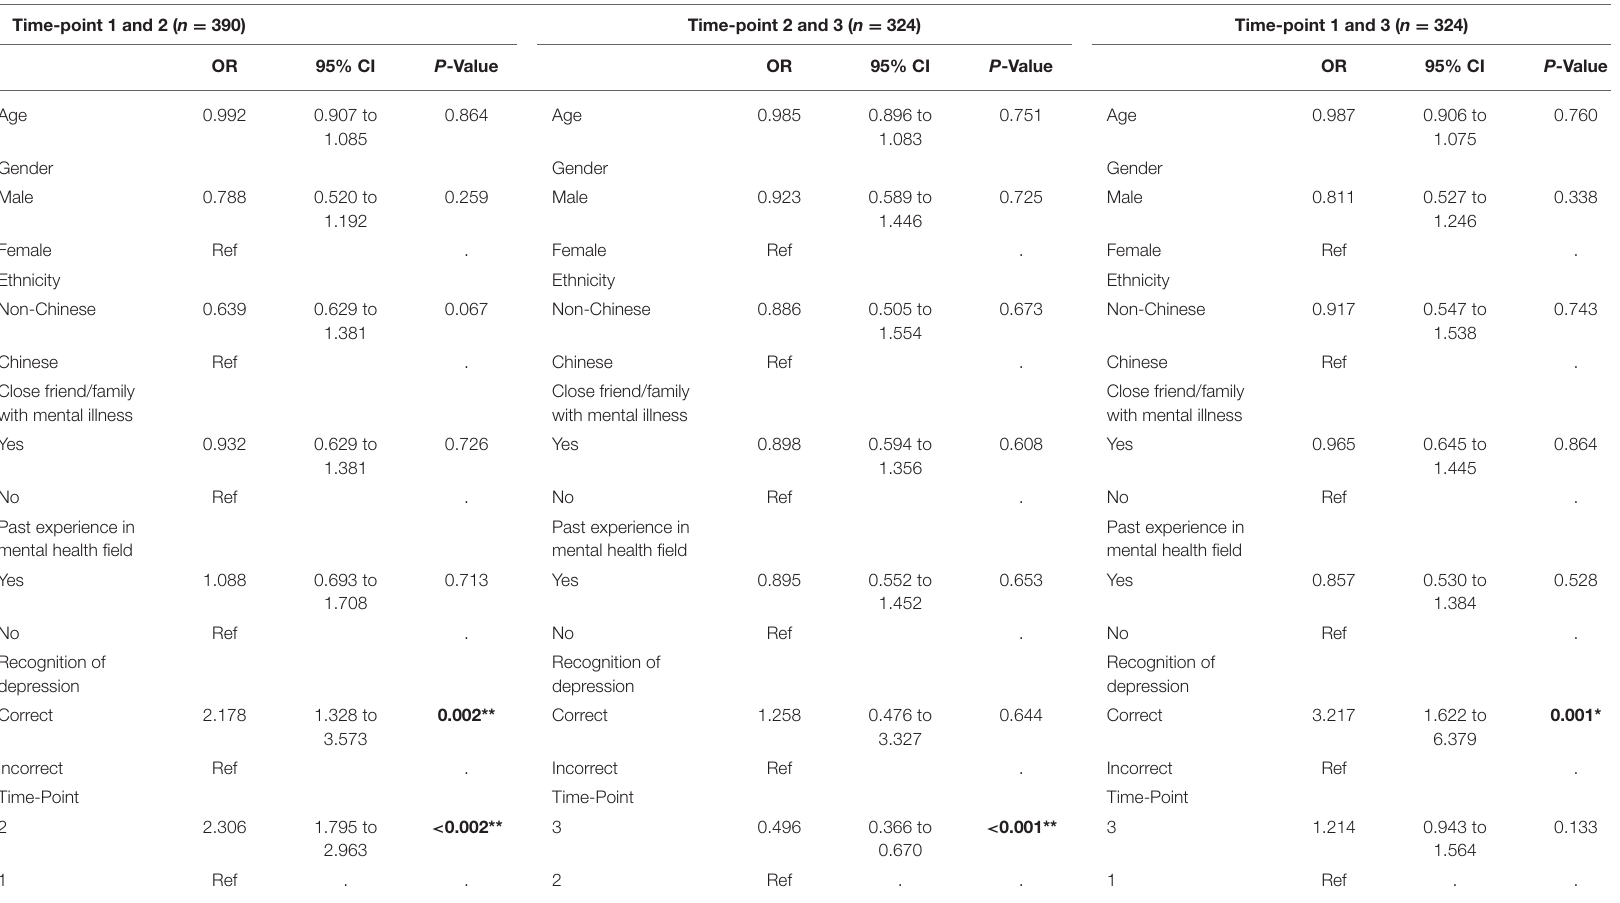
TABLE 5 | Impact of ARTEMIS on help-seeking preferences after controlling for co-variates using Generalized Estimating Equation (non-psychiatric help set as reference group). Time-point 1 and 2 ( n =